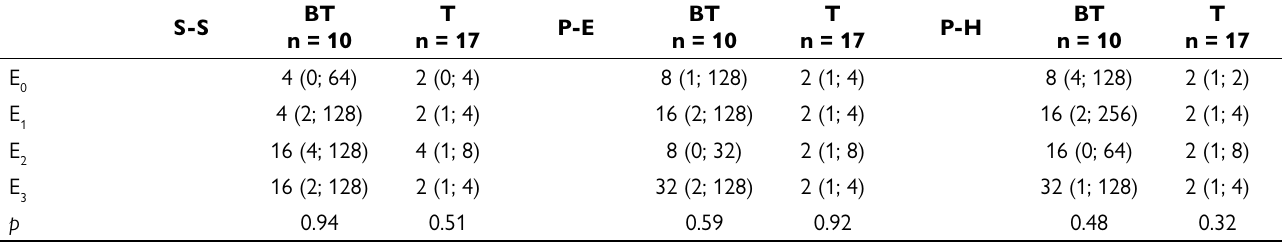
Table 6. Titers of anti- Paracoccidioides brasiliensis antibodies determined by the double agar gel immunodiffusion test in serum (S-S), plasma obtained with EDTA (P-E) and plasma obtained with heparin (P-H). Samples from 27 paracoccidioidmycosis patients, namely 10 untreated (BT) and 17 under antifungal therapy (T). Analysis of the variation of the titers as to the time of storage at –20 o C. Data presented as median, 1 st and 3 rd quartiles, Friedman